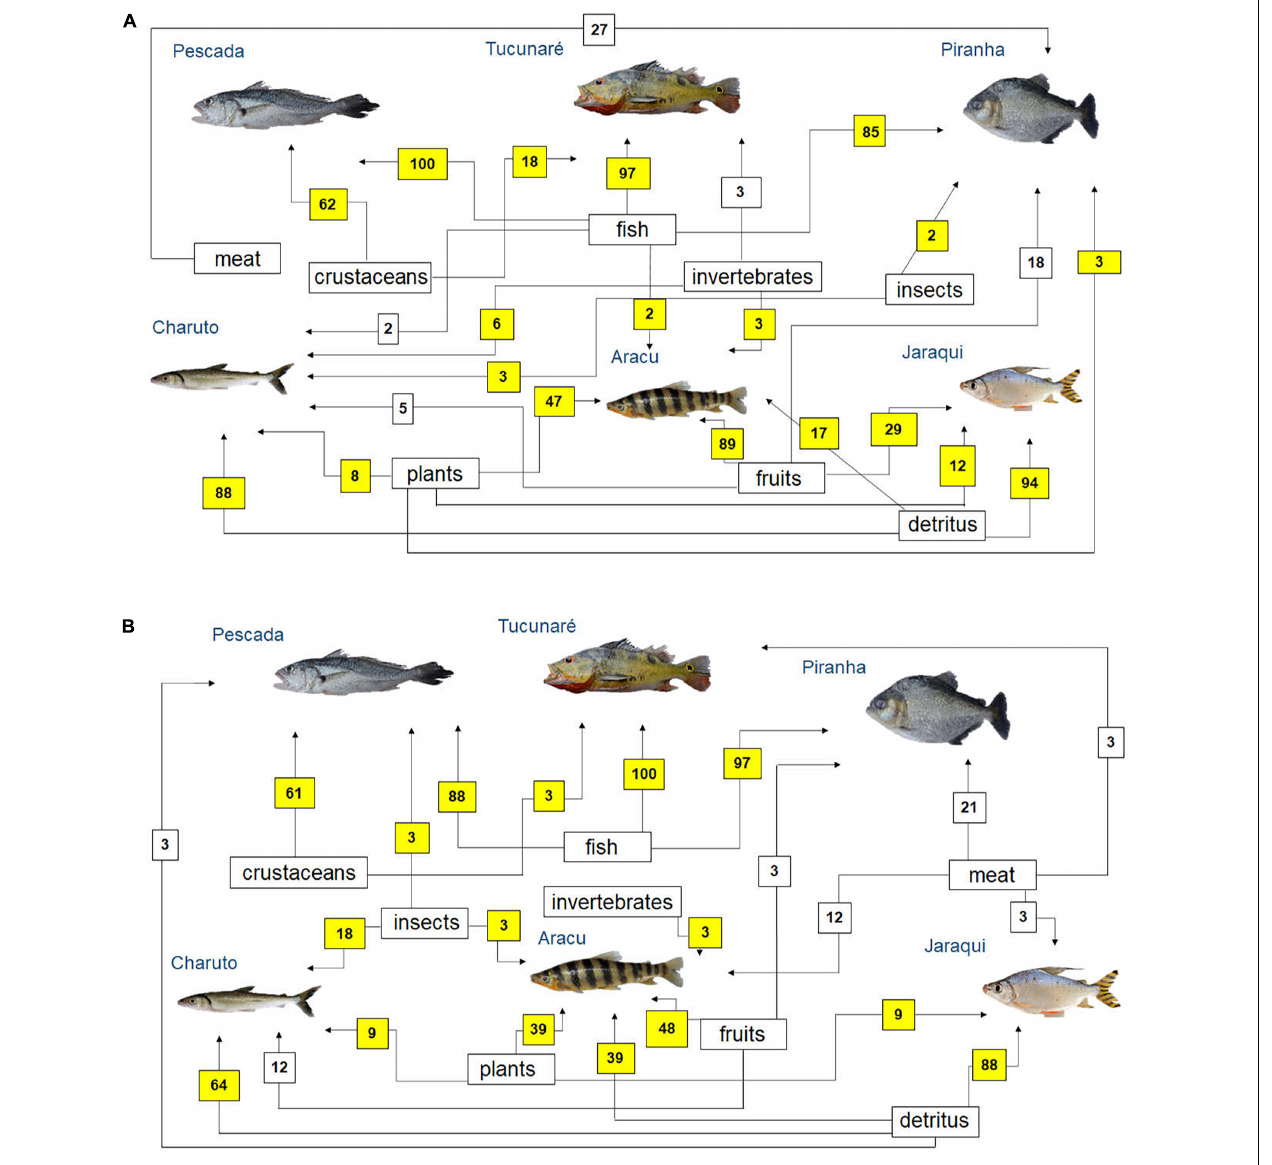
FIGURE 4 | Diagram representing fish feeding relationships (simplified food web) of the studied fish species, based on fishers’ local ecological knowledge about fish prey (question: What this fish eats?) in the rivers (A) Tapajós ( n = 65 fishers) and (B) Tocantins ( n = 33 fishers), in the Brazilian Amazon. The numbers are the percentage of interviewed fishers who mentioned each feeding interaction. The sum may be greater than 100%, as fishers could cite more than one food item for each studied fish species. Those food interactions that agree with fish feeding relationships reported in the biological literature (Mérona et al., 2001; Mérona and Rankin-de-Mérona, 2004; Dary et al., 2017) are marked in